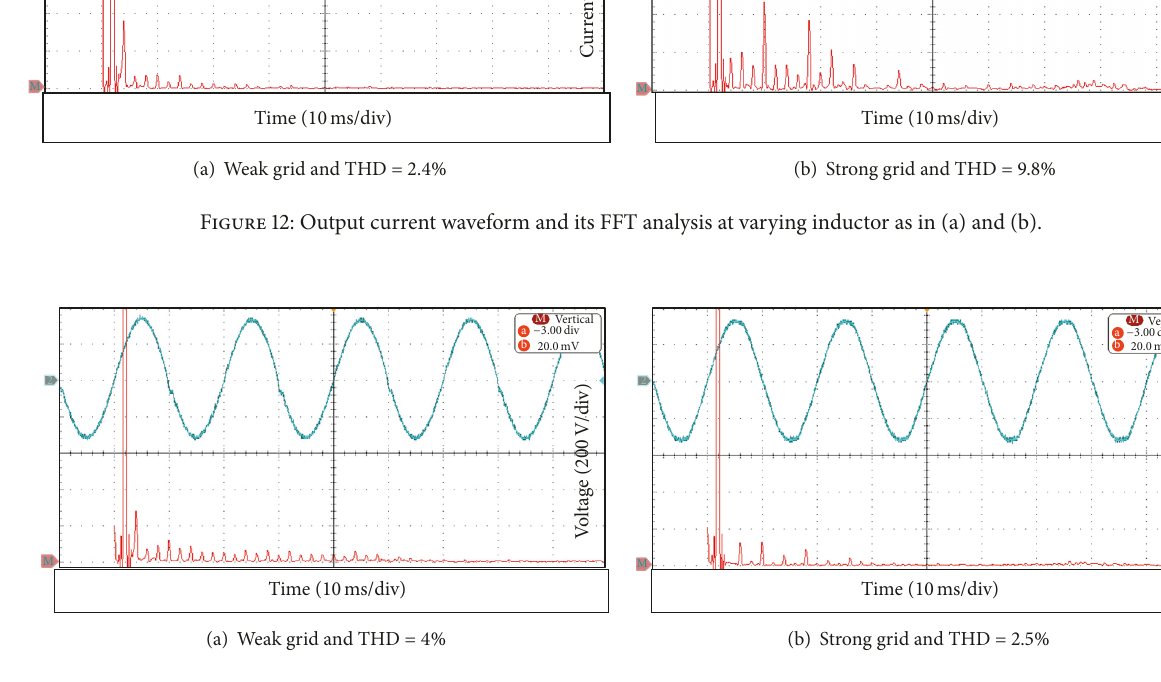
Figure 13: Output inverter voltage waveform and its FFT analysis as in (a) and